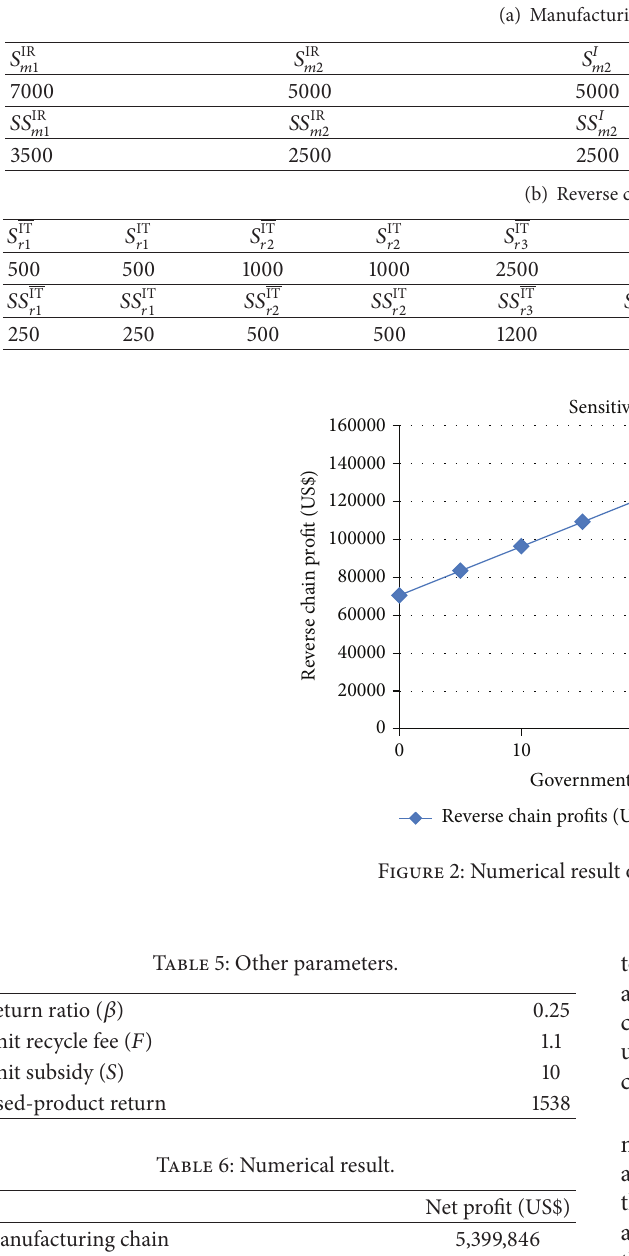
Table 4: Inventory capacity.